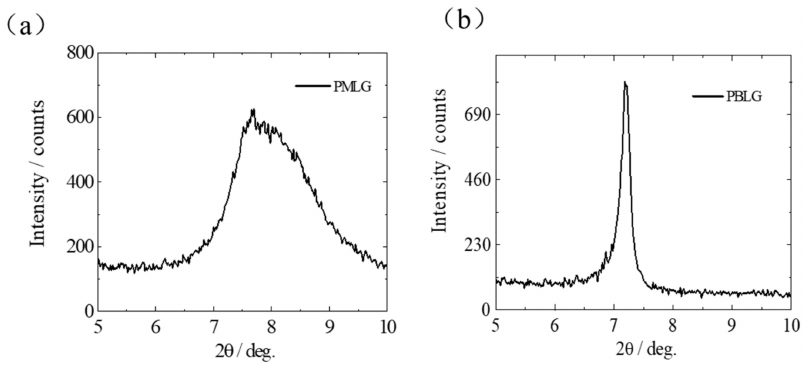
Figure 4. X-ray di ff raction (XRD) curves of the ( a ) PMLG ( b ) PBLG polypeptide thin films.